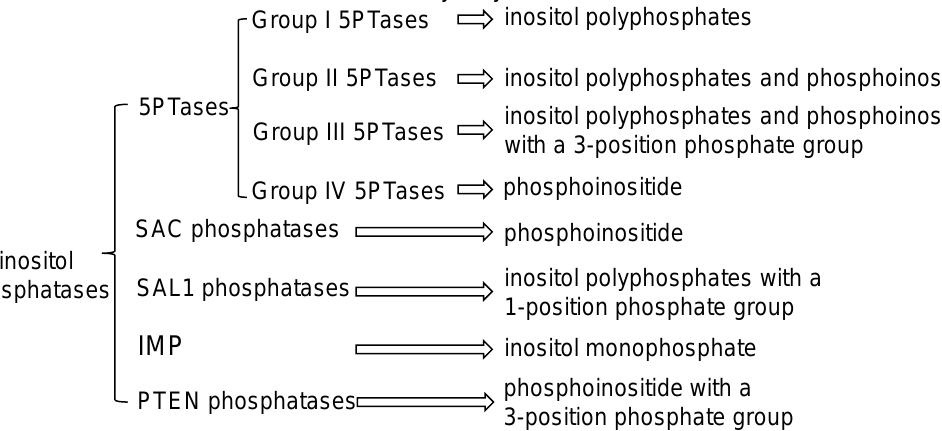
Figure 2. Inositol phosphatases and their inositol-related substrates overviewed in this study. IMP—inositol monophosphatase, PTEN—phosphatase and tensin homologue deleted on chromosome 10, SAC—suppressor of actin, 5PTases—inositol polyphosphate